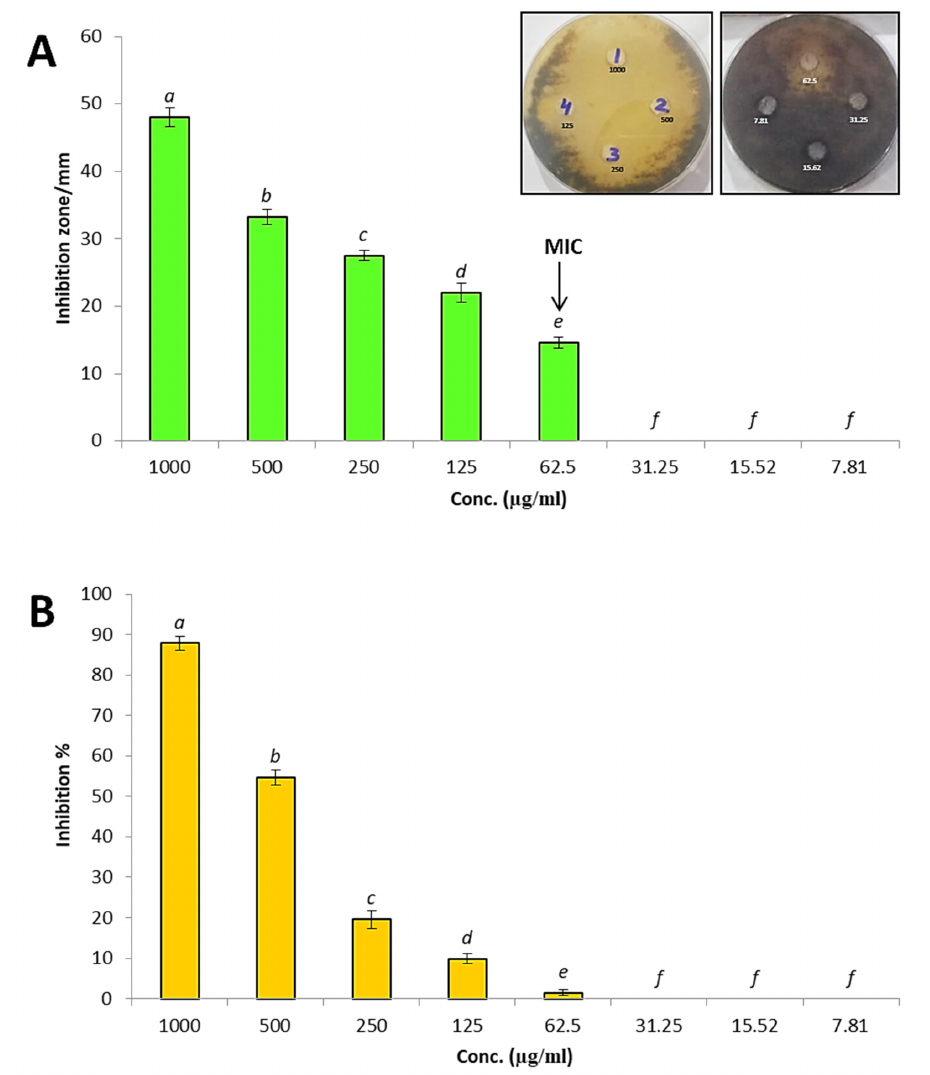
Figure 5. Antifungal activity of SiO 2 -NPs at different concentrations against A. solani ( A , B ): ( A ) Inhibition zones. ( B ) Inhibition percentages. (Data represent mean ± SD, n = 3). (a > b > c > d > e > f revealed to significance power). Numbers 1,2,3,4 in the upper petri dish mean 1000, 500, 250 and 125 µ g/ml.